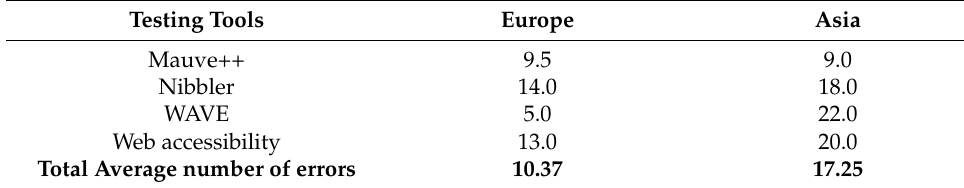
Figure 13. Error ratio of each individual country through automatic tools. Table 12. Average number of errors of each testing